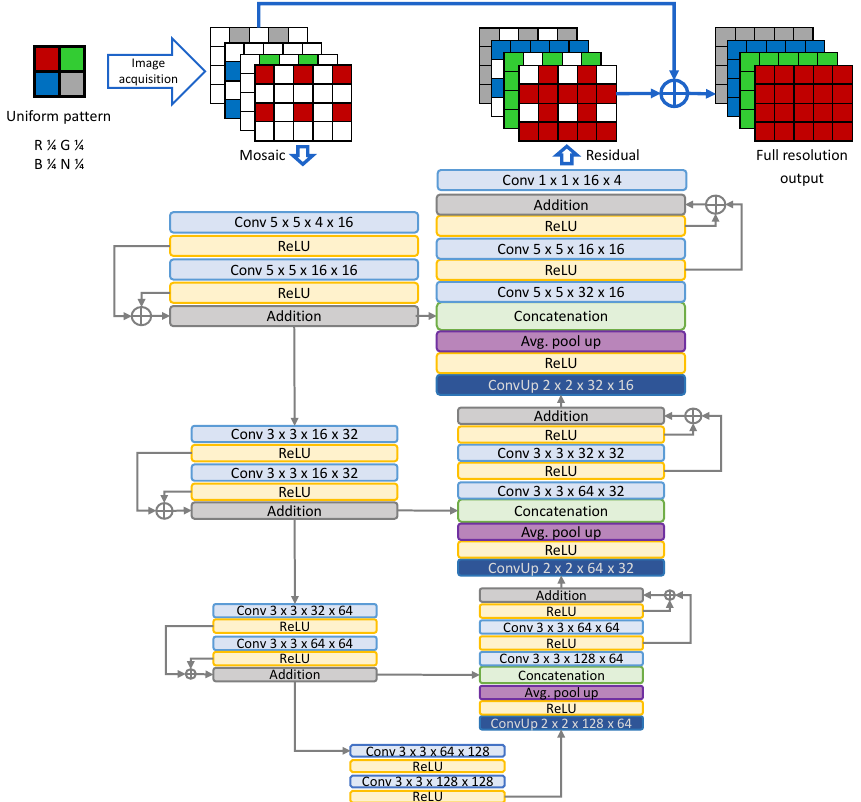
Figure 3. The proposed neural network architecture based on the U-Net model with residual blocks. The network learns to reconstruct the missing information based on the subsampled inputs and combines the output with the original